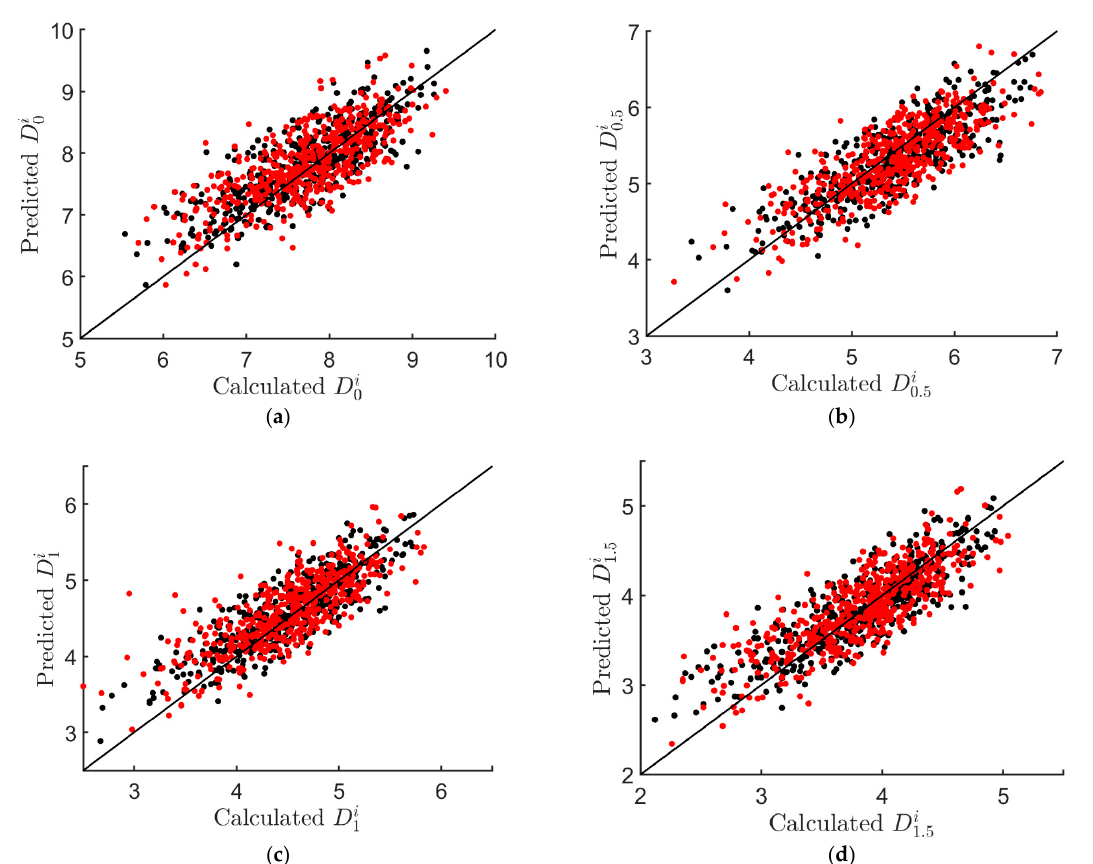
Figure 24. The predictions of influence distance from the numerical simulations and the machine- learning model (black dots = training; red dots = validation): ( a ) MAPE = 4.85% with 𝐷 (cid:2868)(cid:3036) ; ( b ) MAPE = 5.28% with 𝐷 (cid:2868).(cid:2873)(cid:3036) ; ( c ) MAPE = 6.45% with 𝐷 (cid:2869)(cid:3036) ; ( d ) MAPE = 7.81% with 𝐷 (cid:2869).(cid:2873)(cid:3036) .